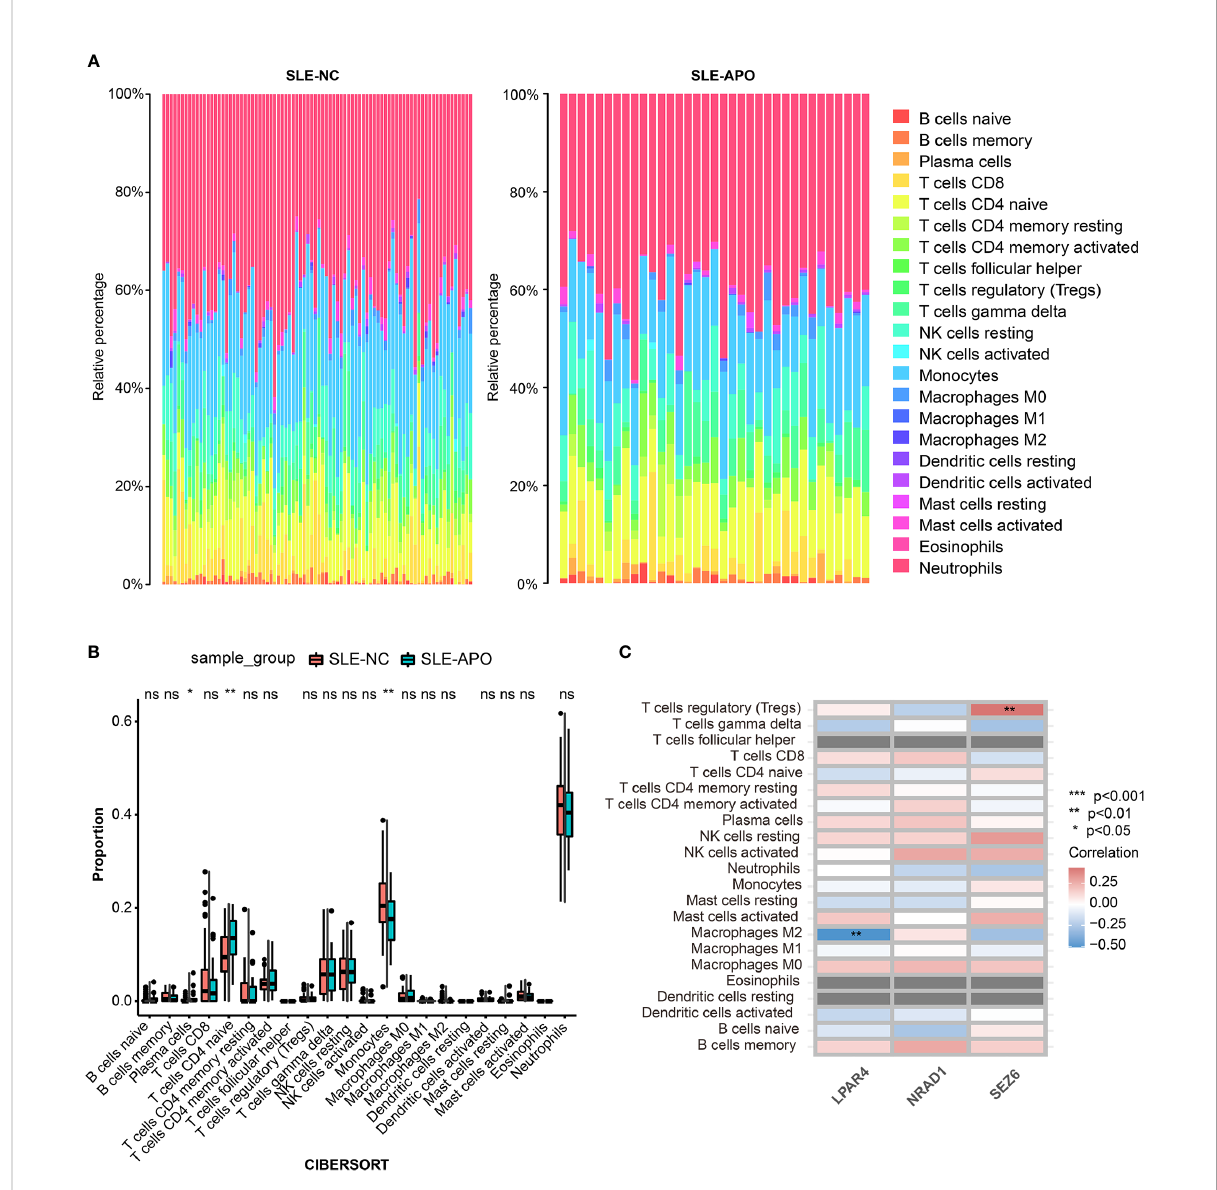
FIGURE 6 Immune cell in fi ltration analysis for SLE-NC and SLE-APO. (A) The proportion of 22 immune cells in SLE-NC and SLE-APO groups quanti fi ed by the CIBERSORT algorithm. (B) The difference of the proportions of 22 immune cells between SLE-NC and SLE-APO groups. (C) The correlation between SEZ6 , NRAD1 , and LPAR4 and immune-in fi ltrating cells in SLE-APO group. * P < 0.05, ** P < 0.01, *** P < 0.001. ns, not signi fi